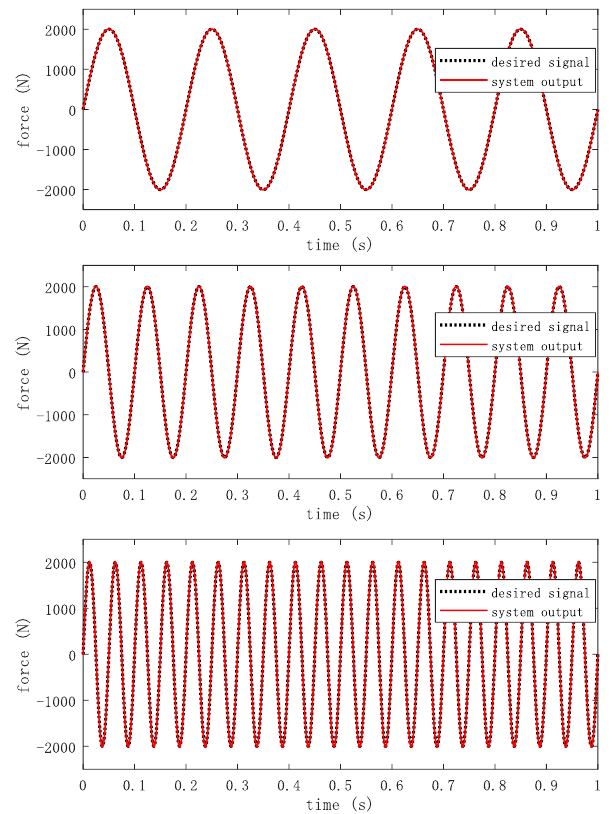
Figure 13. System output curves at different frequencies.